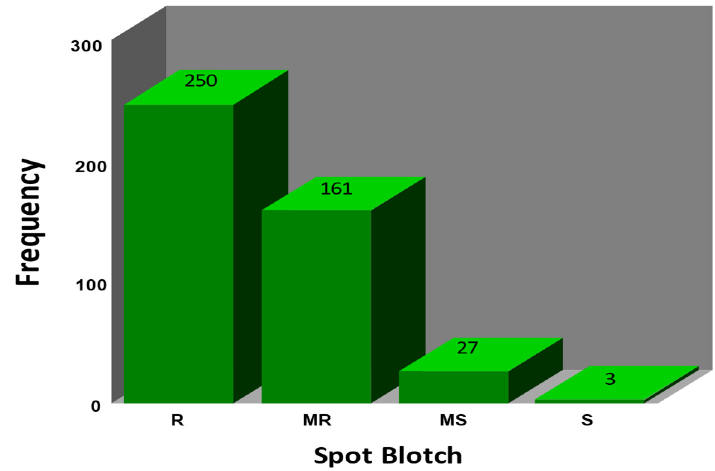
Figure 1. Histogram of spot blotch (SB) scores for different reaction types, which include Resistant (R, 1.0–1.5), Moderately Resistant (MR, 1.6–2.5), Moderately Susceptible (MS, 2.6–3.5), and Susceptible (S, 3.6–5.0).(data extracted from Supplementary Table S1).